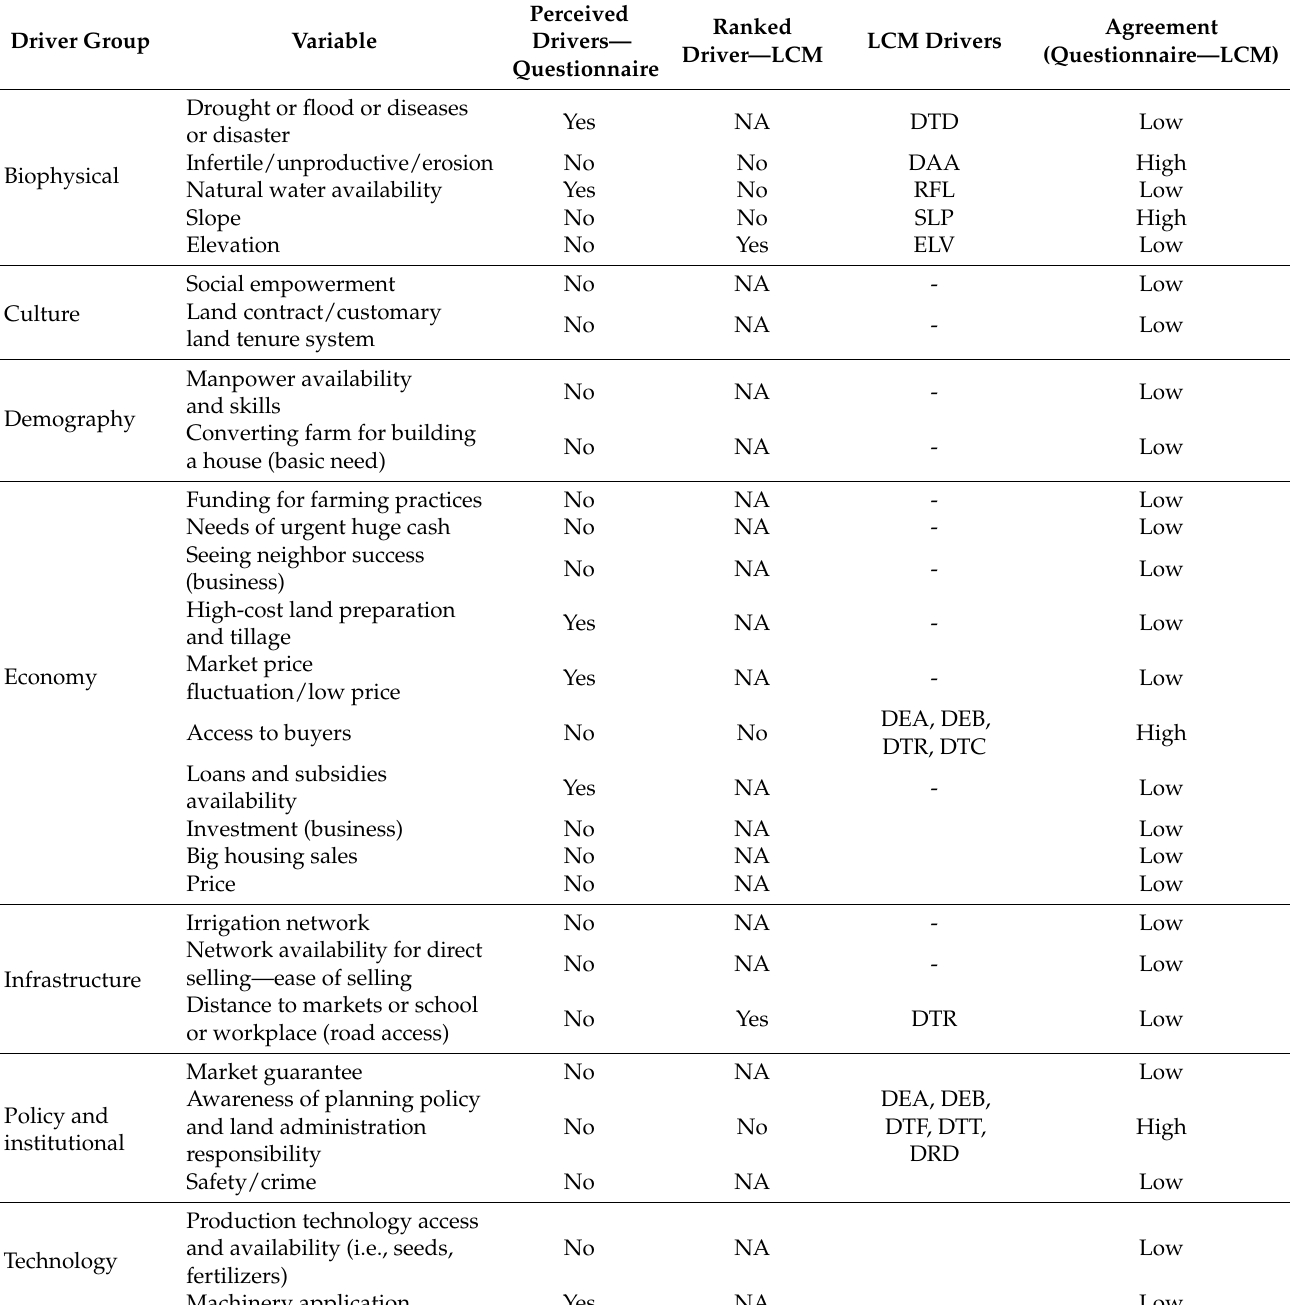
Table 6. Agreement of inferred drivers from questionnaires and geo-statistical